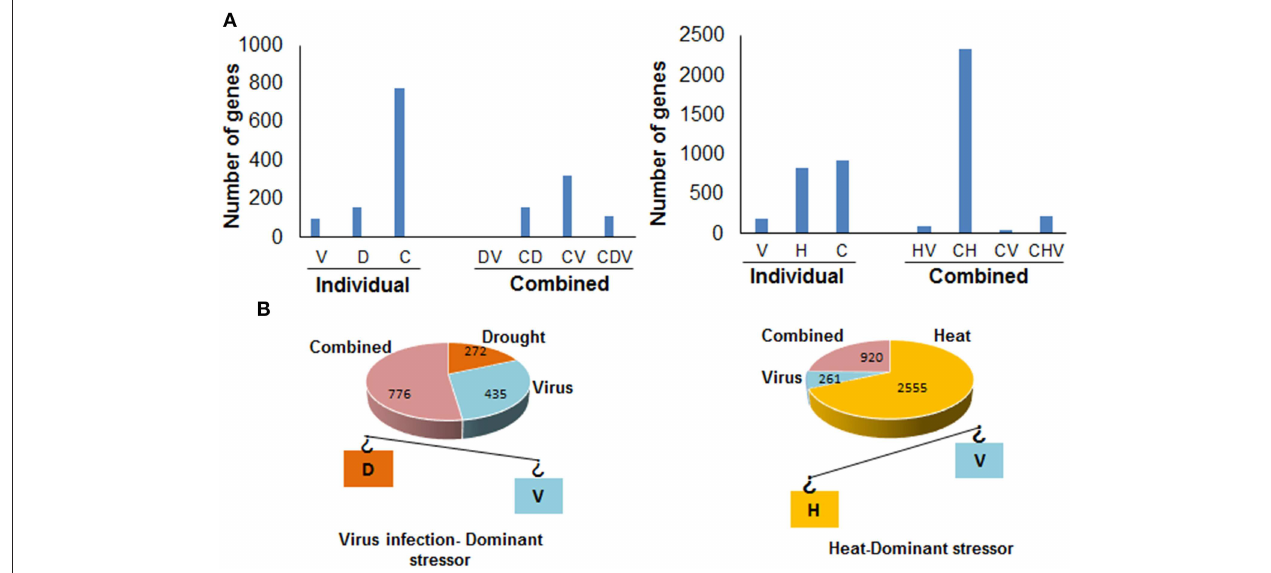
FIGURE 2 | Unique and shared responses and the “dominant stressor” concept in A. thaliana under combined heat, virus, and drought stress. (A) Representation of unique and shared responses of A. thaliana under drought, virus infection, and their combination(left) and heat, virus, and their combination (right). The bar diagram (left) represents the number of genes modulated exclusively under virus (V), drought (D), combined heat and drought stress (C) as well as the number of commonly regulated genes under virus infection and drought stress (DV), drought and combined (DC), virus and combined stresses (VC), and all the three stresses (CDV). The bar diagram at the right represents the number of unique genes modulated exclusively under virus (V), heat (H), combined heat and virus stress (C) as well as the number of genes commonly regulated under heat and virus infection (HV), heat and combined (CH), virus and combined stresses (CV), and all the three stresses (CHV). (B) The figure represents the dominant stressor concept. Drought and virus stress are represented by orange and blue rectangles. In this case, virus infection has more effect on the gene expression of A. thaliana plants. The number of genes unique to combined stress is far greater than that of individual stress genes and molecular response to the combined stress conditions is mostly unique. Heat and virus stress are represented by yellow and blue rectangles. In this case, heat stress has more effect on the gene expression. The number of heat and combined stress genes are nearly same and molecular response to the combined stress conditions mostly consists of genes commonly modulated under heat and combined stress. The figure is a graphical representation of the data provided in microarray study by Prasch and Sonnewald (2013). H, heat; D, drought; C, combined